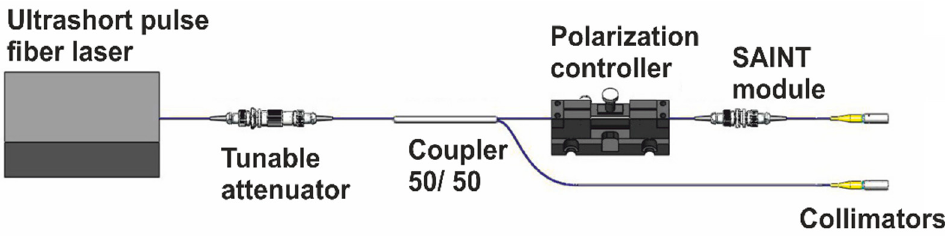
Figure 3. Setup for experimental measurement of a HDWA-SWCNT thin film optical loss.